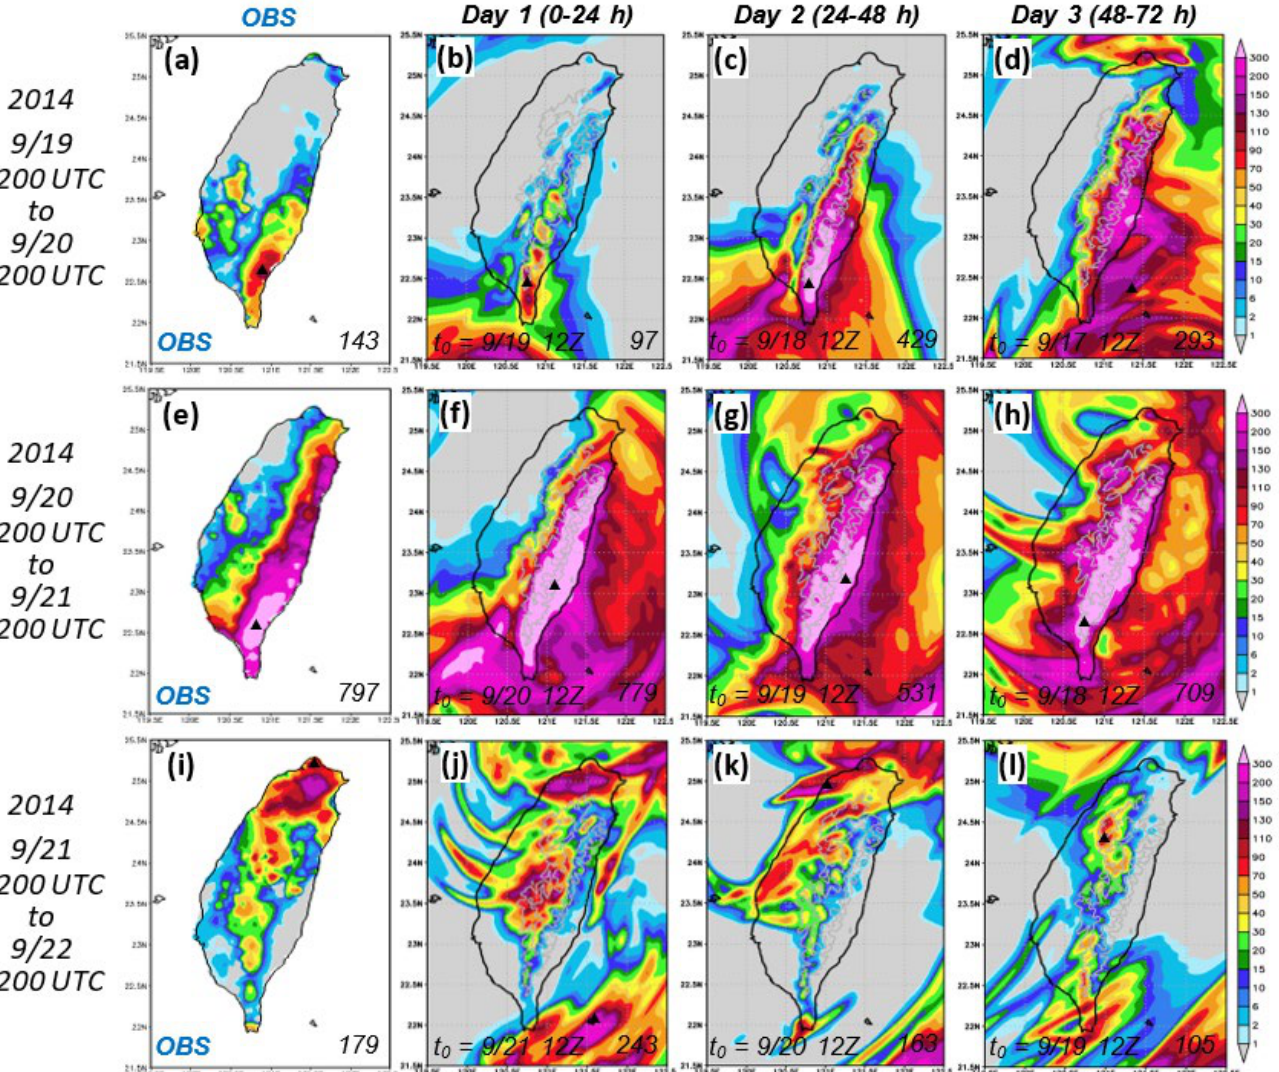
Figure 7. As in Figure 4, except for the rainfall distribution (mm) in observation (first column) and CReSS QPFs at ranges of days 1–3 (second to fourth column), valid for the 24 h period starting from 1200 UTC of ( a – d ) 19 September, ( e – h ) 20 September, and ( i – l ) 21 September, respectively, during TY Fung-Wong (2014).